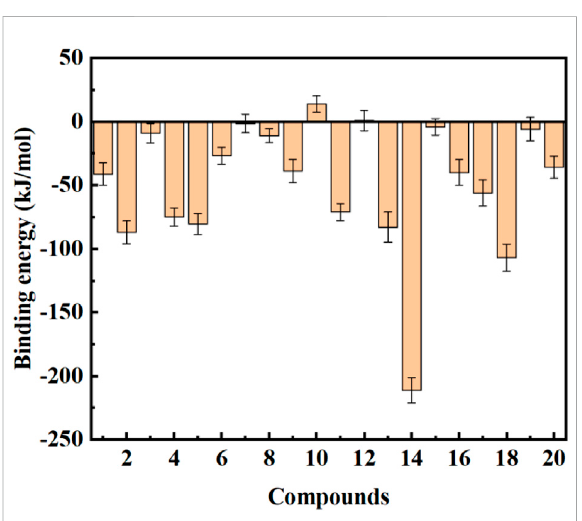
FIGURE 11 Binding free energy calculation between the COVID-19 M pro and the top 20 compounds screened by normalized